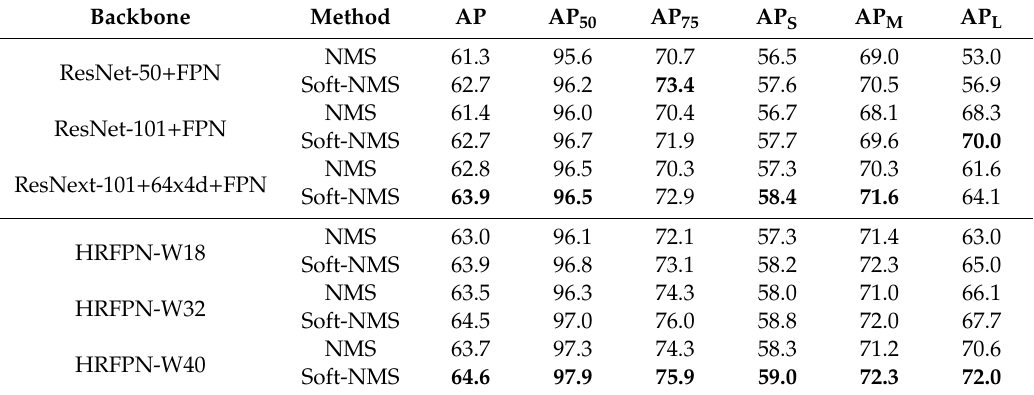
Table 4. Results on SSDD for HR-SDNet which use NMS as a Baseline and the Soft-NMS